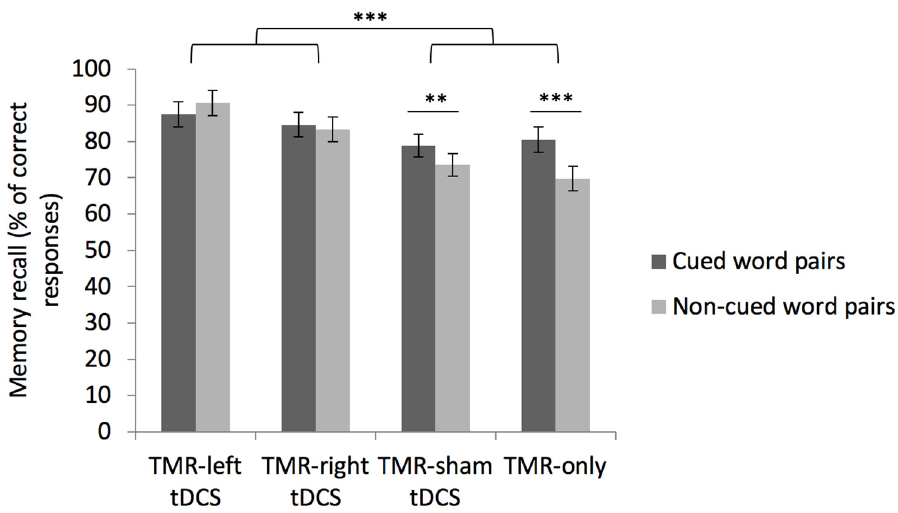
Figure 4. Memory performance for cued and non-cued word pairs at the first recall task (RT1) in the four conditions. Error bars illustrate standard error. ** p < 0.01, *** p < 0.001.